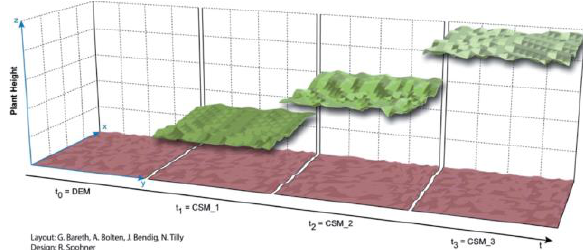
Figure 3. UAV-based plant height analysis with multi-temporal crop surface models (CSMs) (Bendig et al. 2013) The non-calibrated, UAV-derived RGB imagery was used